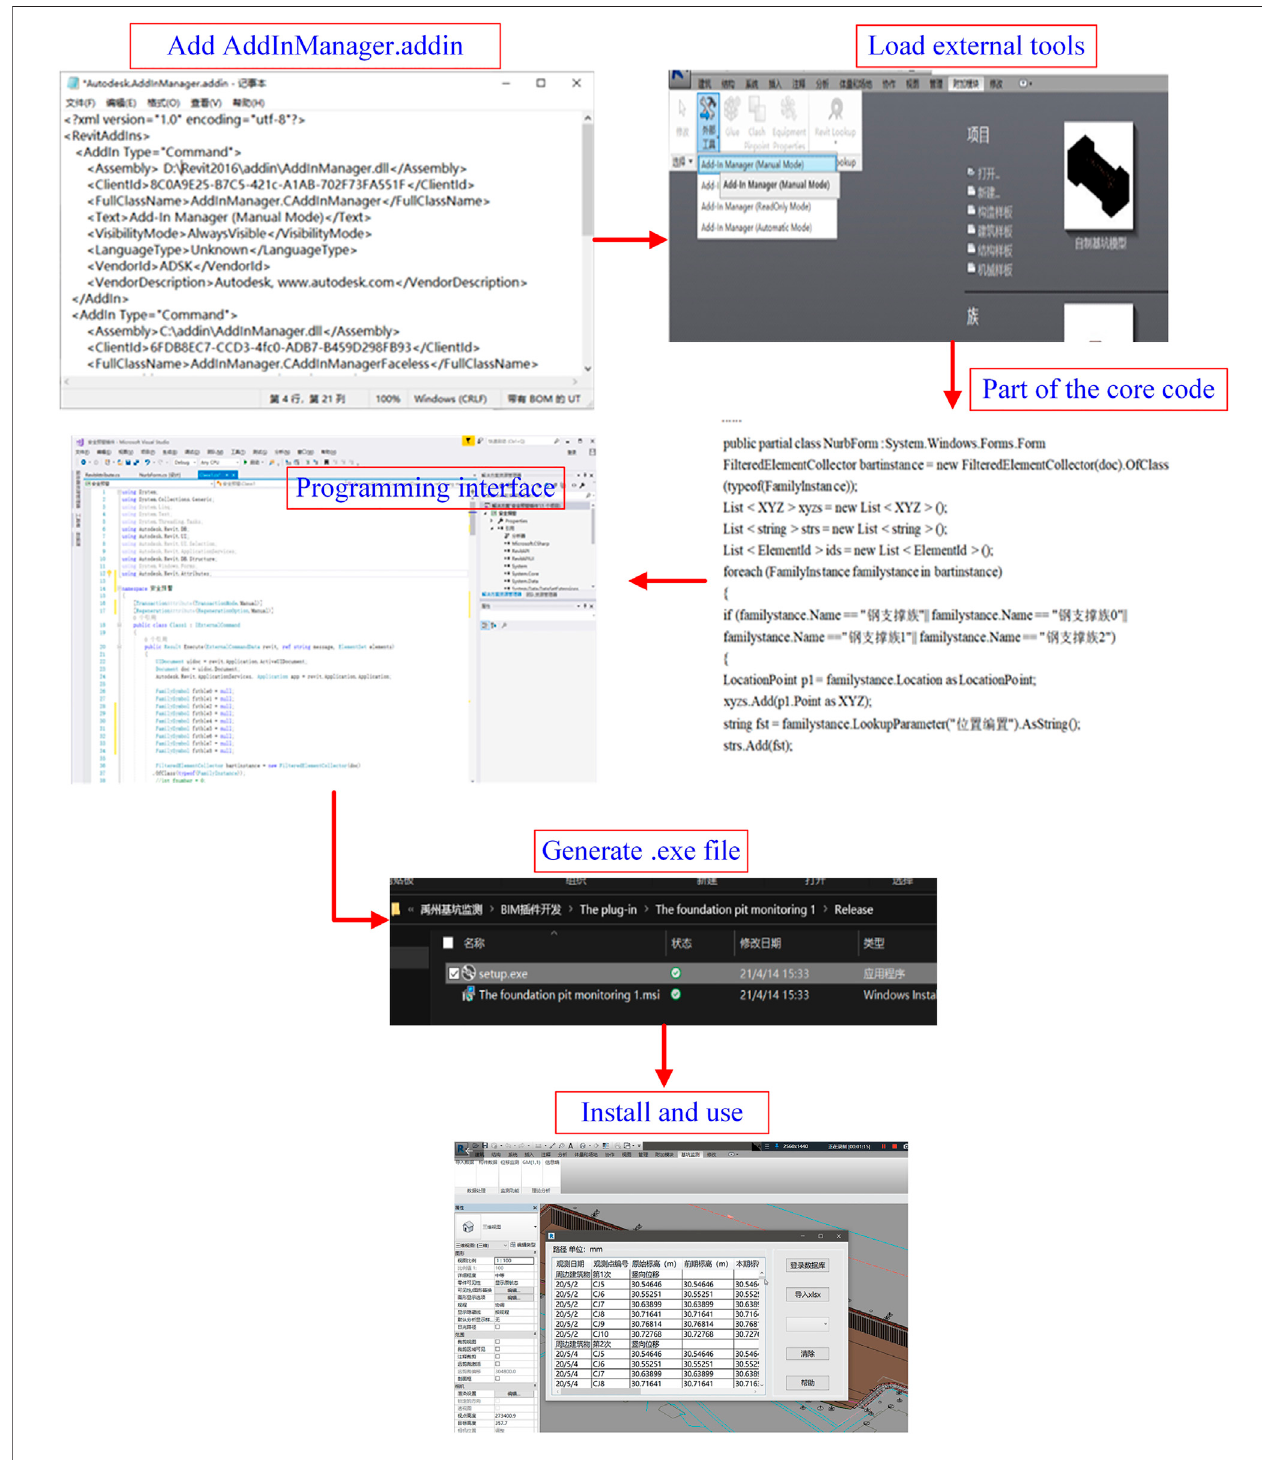
FIGURE 3 | The speci fi c implementation path of the secondary development based on Revit.